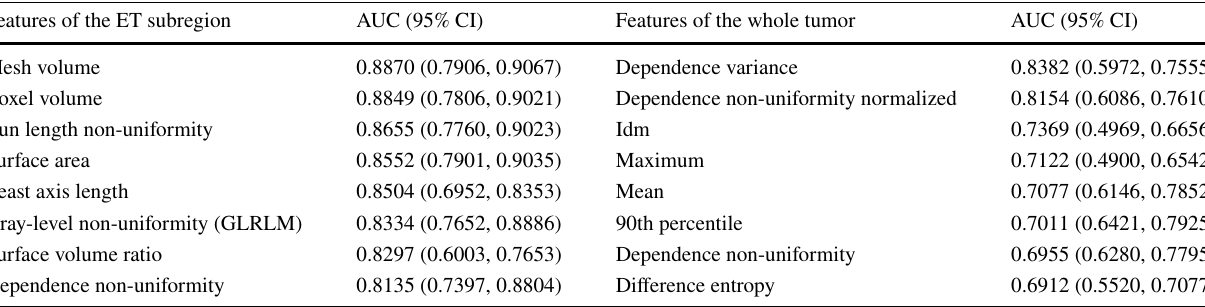
Table 4 Comparative results of AUC of the eight top-ranked features from the T1Gd-based ET subregion and whole tumor for glioma grade Features of the ET